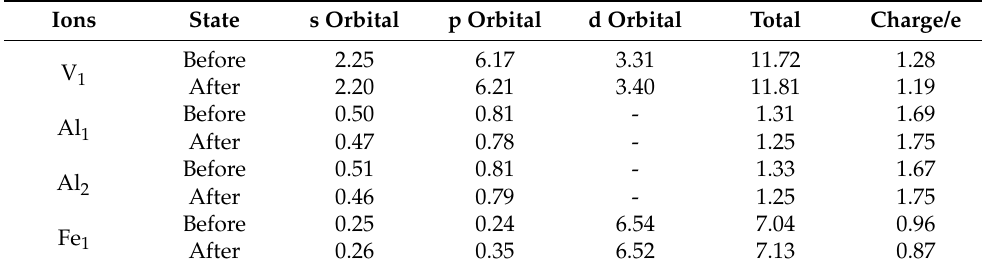
Table 4. Mulliken population of atoms before and after dehydroxylation.